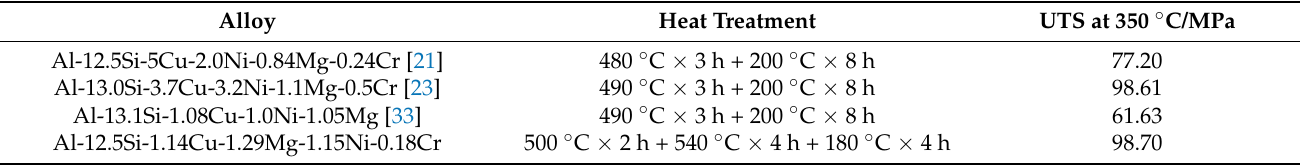
Table 3. The alloy variations and testing types.